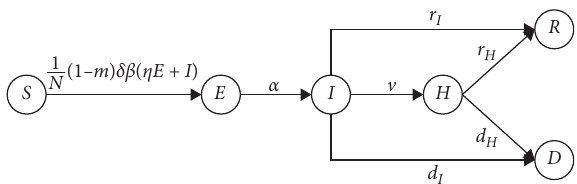
Figure 1: Diagram of population transformation of the novel